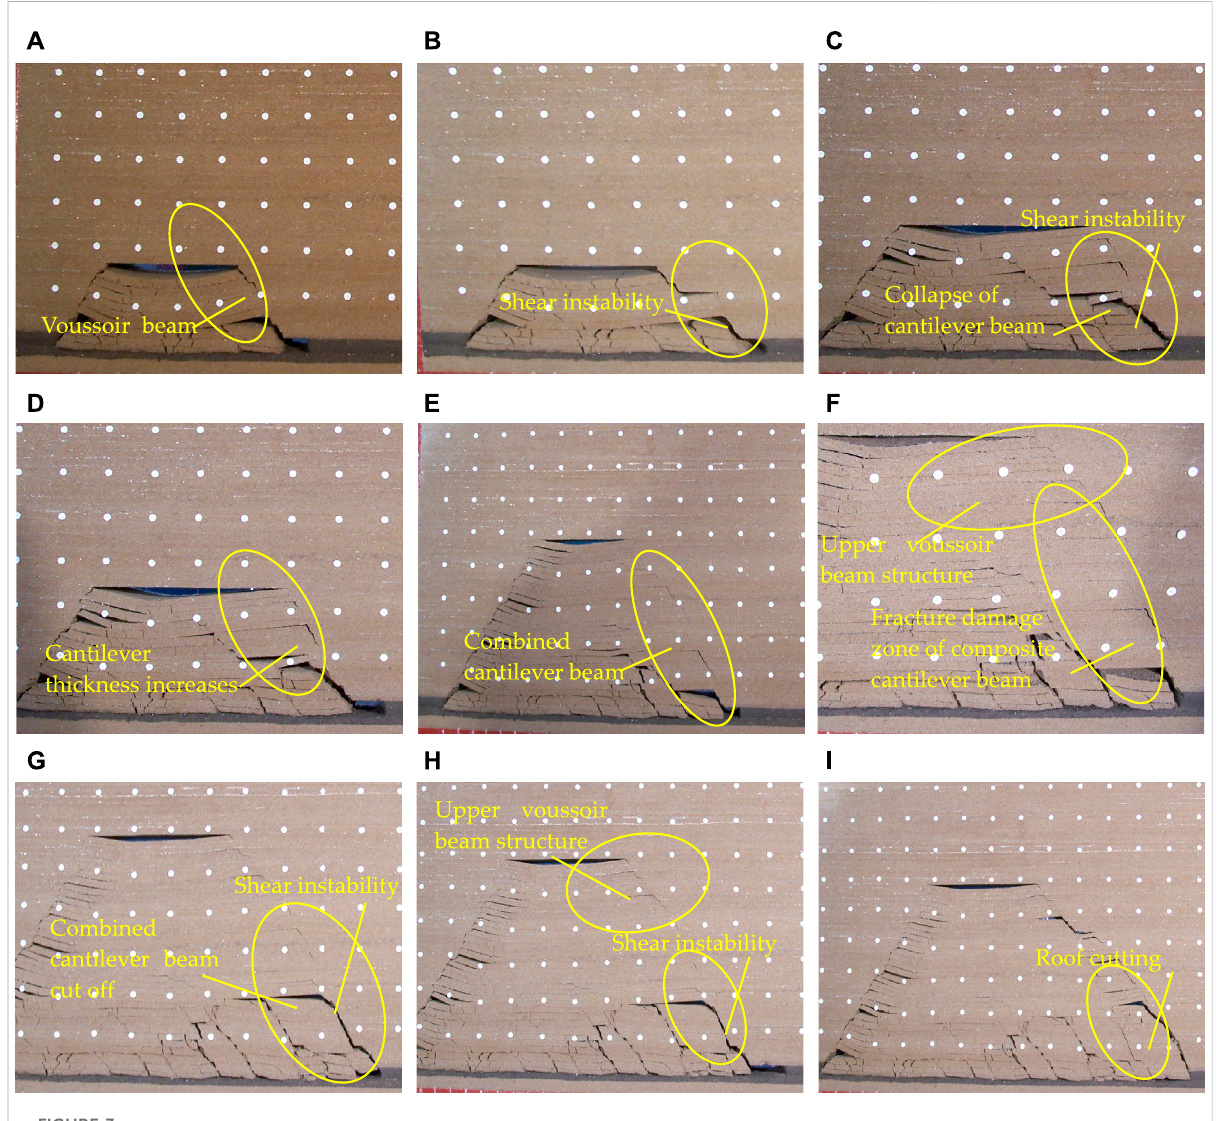
FIGURE 3 Simulation test results of similar